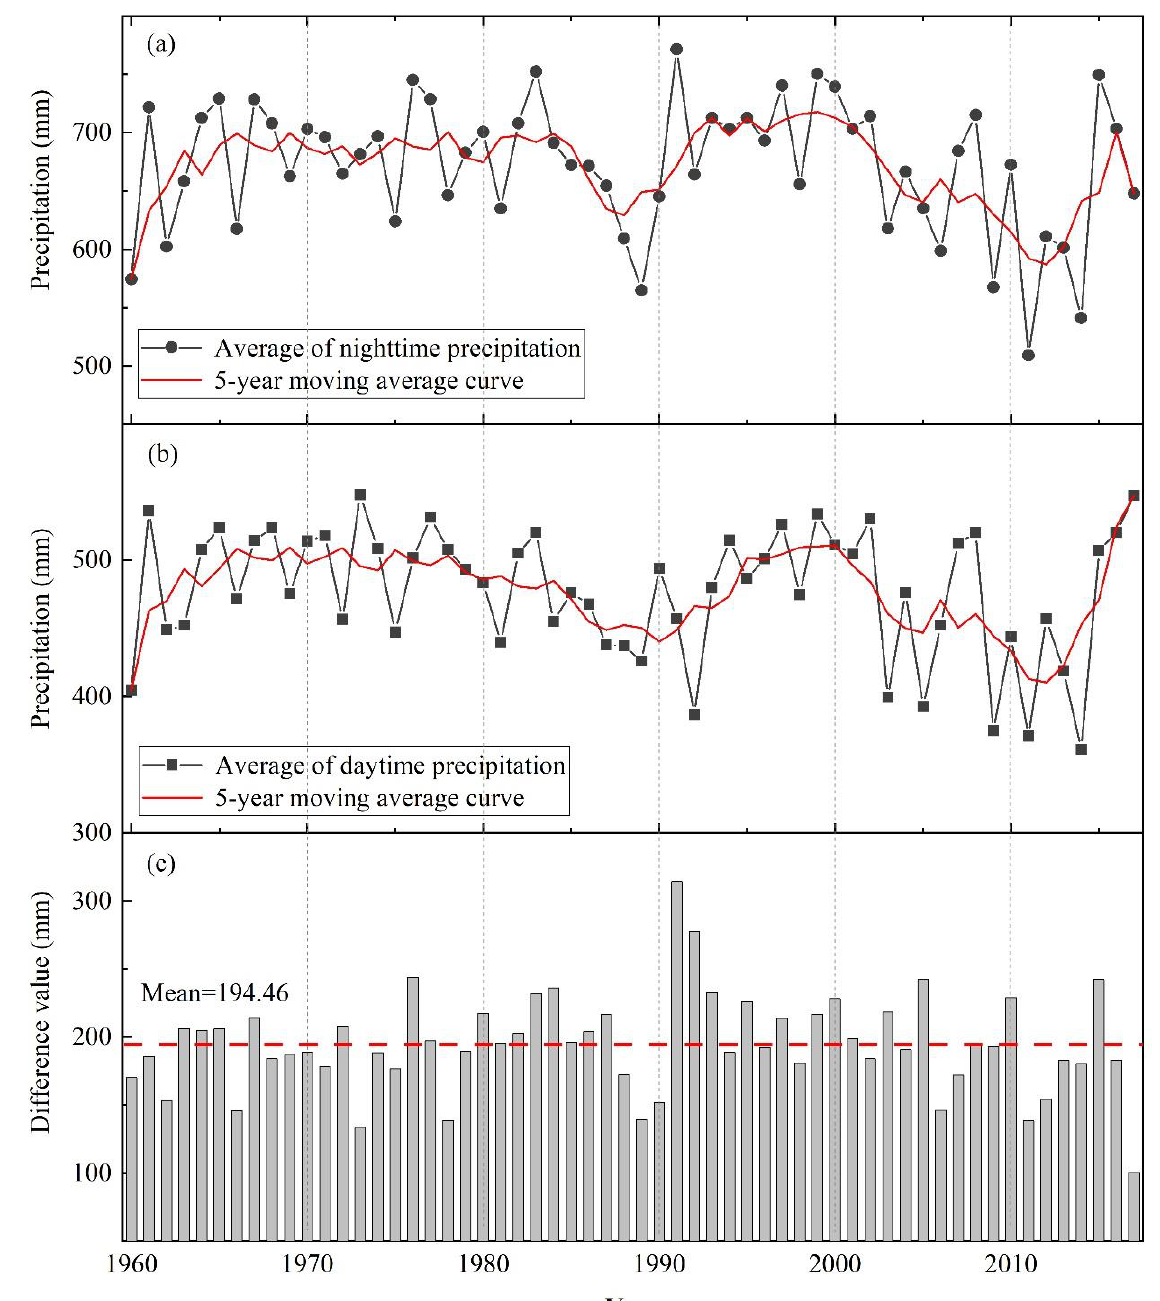
Figure 4. Variation in daytime and night-time precipitation on Yunnan – Guizhou Plateau.